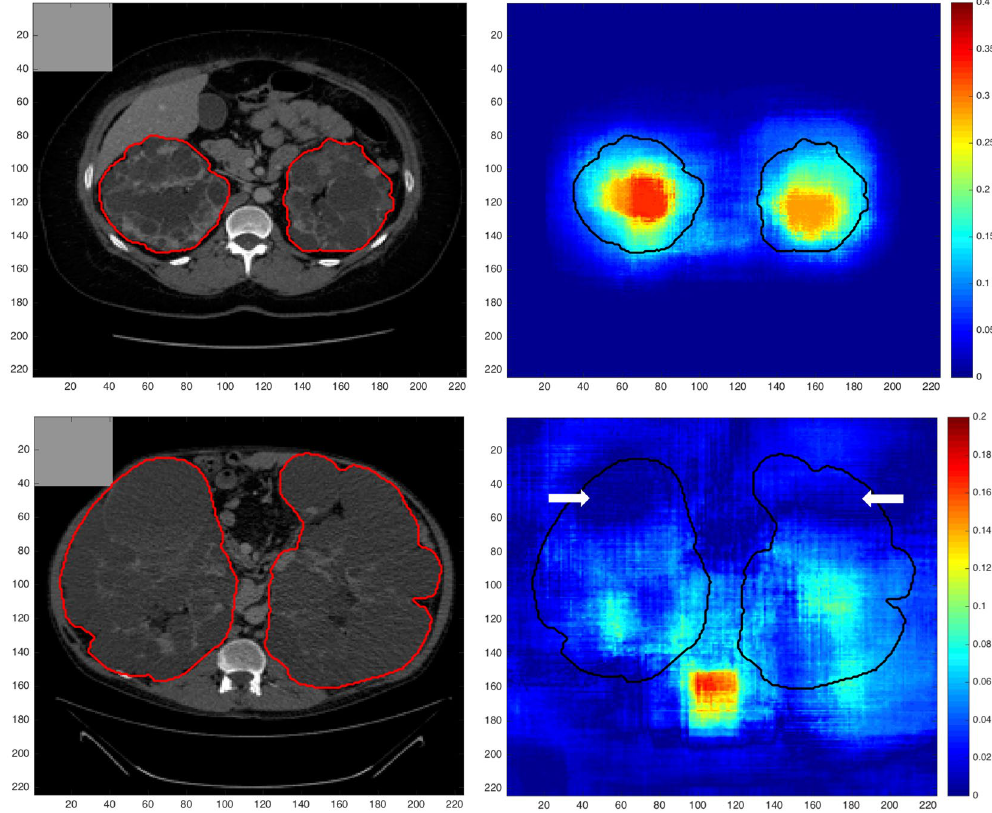
Figure 5. Feature Visualization. Segmentation maps measuring change in DSC while occluding (shown with gray square) different parts of the image with respect to original unoccluded image as a measure of importance for the respective image region. The manually generated outline of the kidney is shown in red and black, respectively. Top: The largest change occurs when the kidneys themselves are occluded. Bottom: Same experiment for an ADPKD patient with high TKV ( > 13,000